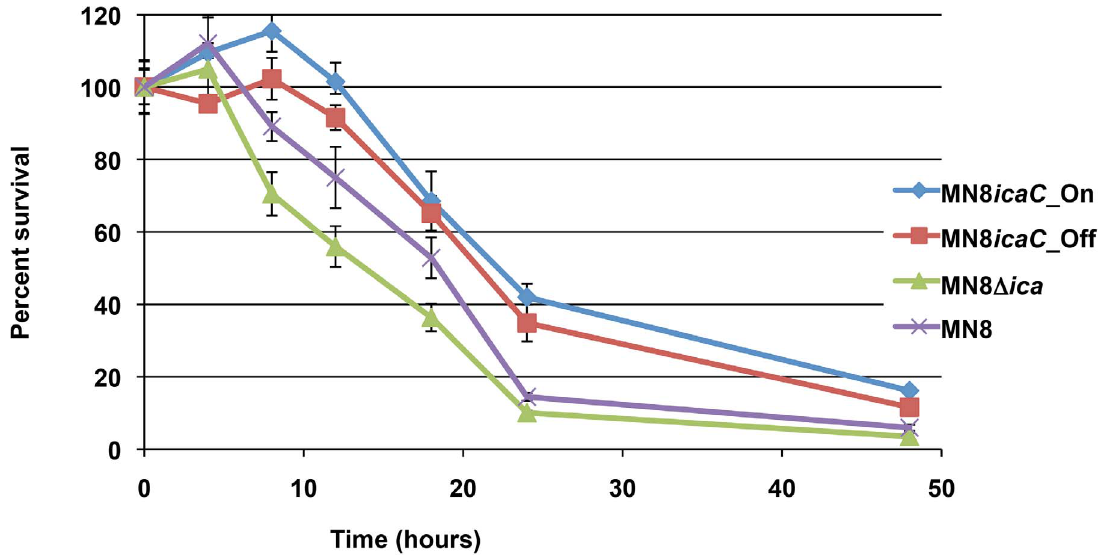
Figure 7. Survival in minimal media. MN8m, JB12, and MN8 D ica were grown in TSBG. The cells were collected and resuspended in minimal media lacking a carbon source to mimic starvation conditions. Points represent the mean percent value of cells enumerated at each time point relative to the starting populations with n=3, and error bars indicate the standard deviations. Statistical comparison (unpaired t test) of MN8m versus JB12 and MN8 D ica versus JB12 at 8 hours and 10 hours gave a P value of , 0.0001. Comparison of MN8m versus JB12 and MN8 D ica versus JB12 at 18 hours and 24 hours gave a P value of , 0.001.